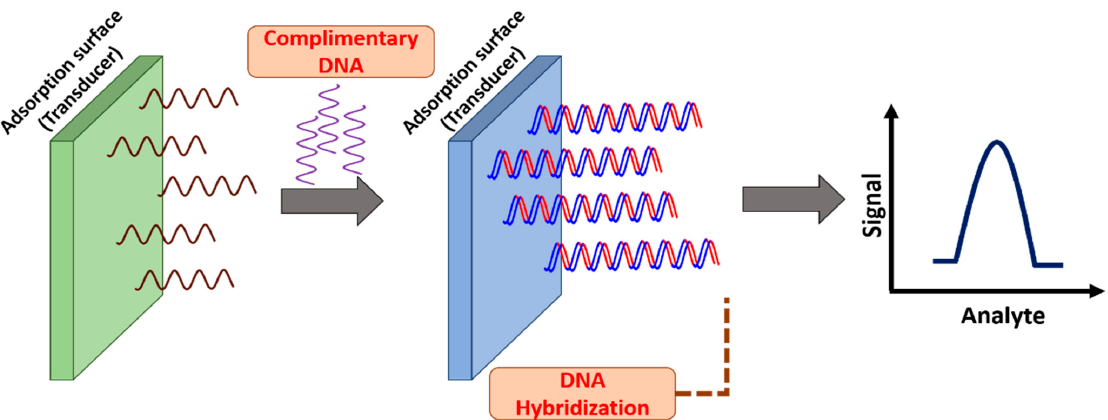
Figure 3. The bioreceptor component in nucleic acid-based biosensors for detecting nucleic acids resembles the hybridization process between DNA probe and target